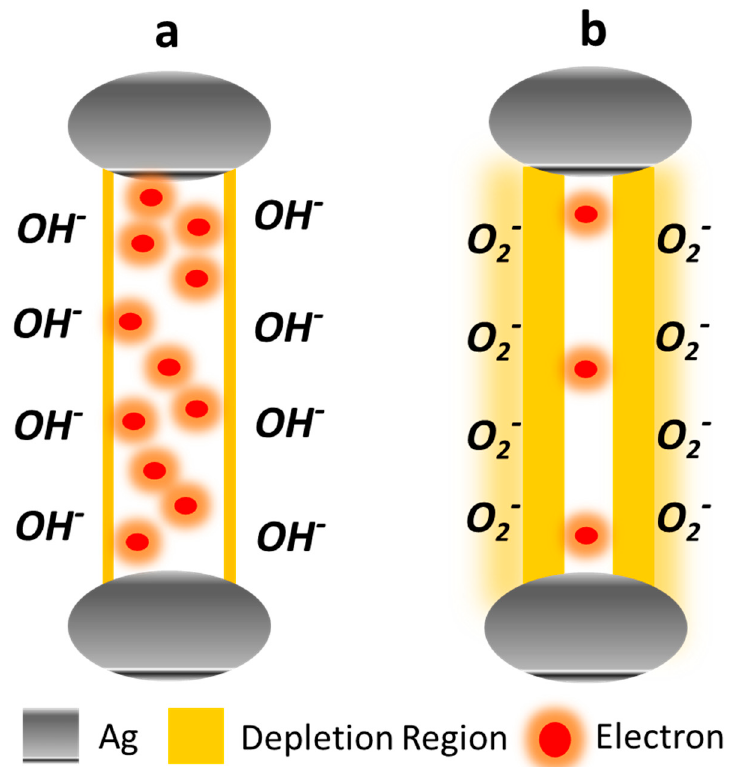
Figure 7. Channel layer e distribution and surface Schottky barrier in ( a ) defect-prone S1 and S2 with OH– surface accumulation layer and ( b ) defect-free S3 with chemisorbed surface oxygen.